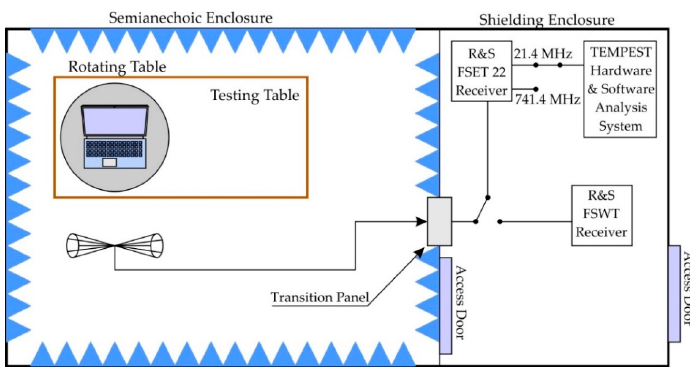
Figure 3. Telecommunications Services test bed.